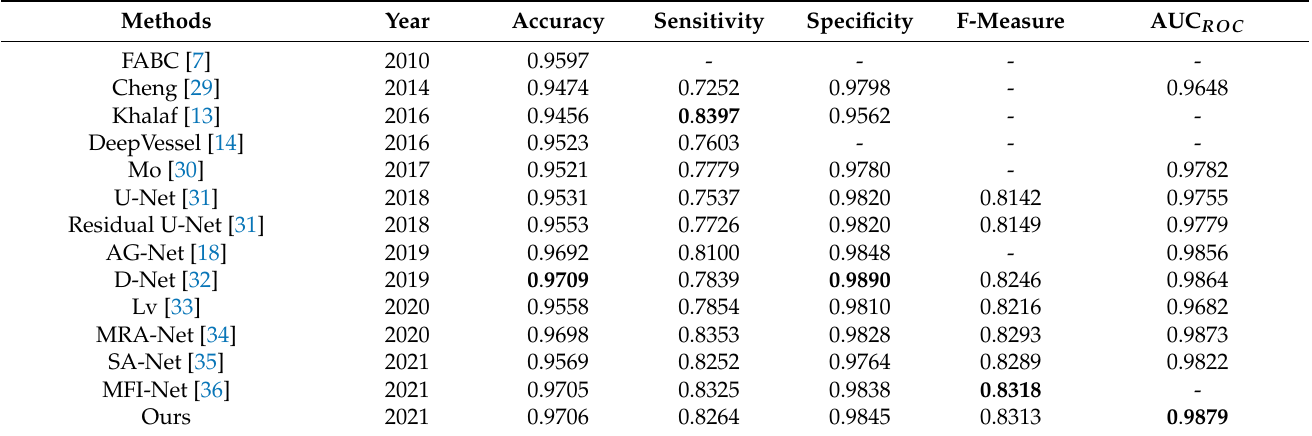
Table 3. Comparison of the proposed methods with other methods on the DRIVE dataset.